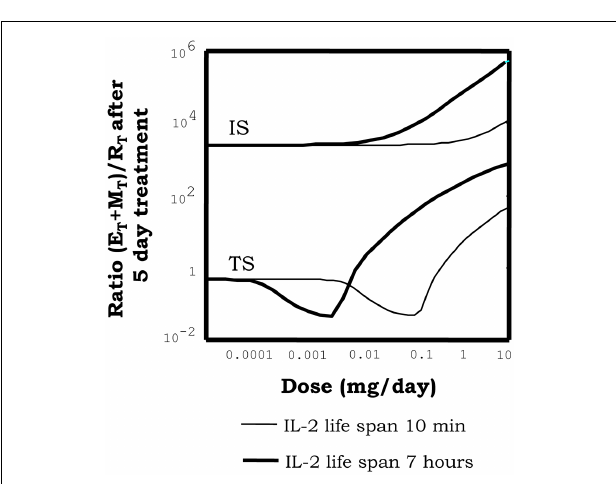
FIGURE 5 | Effect of injections of IL2, on the proportion of helper + memoryT cells versus regulatoryT cells [ratio (E + M)/R], in a system initialized either in tolerant (TS) or the autoimmune (IS) steady state .The graph shows the ratio (E + M)/R attained in the system right after 5days of continuous injections of the indicated dose ( x axis of the graph) of an IL2 with either 10min (thin curves) or 7h (thick curves) life span in solution. It can be seen how when the simulations start with a system at theTS, the ratio (E + M)/R reduce its values for intermediate dose of the treatment.This is a direct consequence of a preferential expansion of the R cells in the system. However, if the dose is further increased then the ratio (E + M)/R is significantly increased.This is a direct consequence of the expansion of helper and memoryT cells, by the treatment application. When the treatment start on a system at the IS, then increasing the dose always leads to an increase of the ratio (E + M)/R.This is, it further increments the number of E and R cells in the system. Interestingly increasing the life span of the injected IL2 moves to lower values the dose ranges where treatment is effective, but does not change the qualitative pattern of response